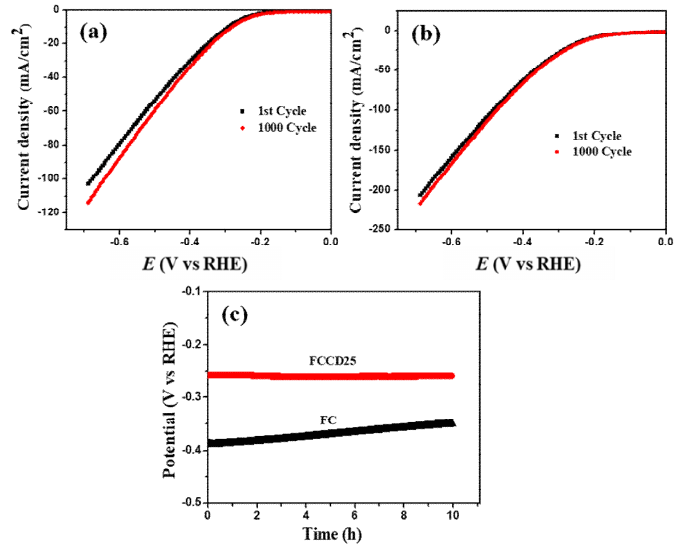
Figure 5. HER polarization curves of ( a ) FC, ( b ) FCCD25 before and after 1000 CV cycles, ( c ) chronopotentiometric study at a constant current density of 10 mA cm −2 . All the electrocatalysts grown on Ni foam were checked for their OER activities (electrolyte: KOH 1 M). Figure 6a shows that FCCD25 possessed a much higher activity than other electrocatalysts. A strong peak of Co 3+/ Co 4+ (1.25–1.5 V) can be found in Figure 6a, which is more prominent for FCCD25, implying that FCCD25 can facilitate the oxidation and promote the OER process [68]. To generate a current density of 50 mA cm −2 , FCCD25 required an overpotential up to 393 mV, while other electrocatalysts needed much higher overpotentials (Figure 6b). Furthermore, the Tafel slope for FCCD25 was found to be 105 mV dec −1 (Figure 6c). In contrast, a high Tafel slope was obtained for FC (237 mV dec −1 ), FCCD5 (183 mV dec −1 ) and FCCD40 (191 mV dec −1 ). Therefore, it